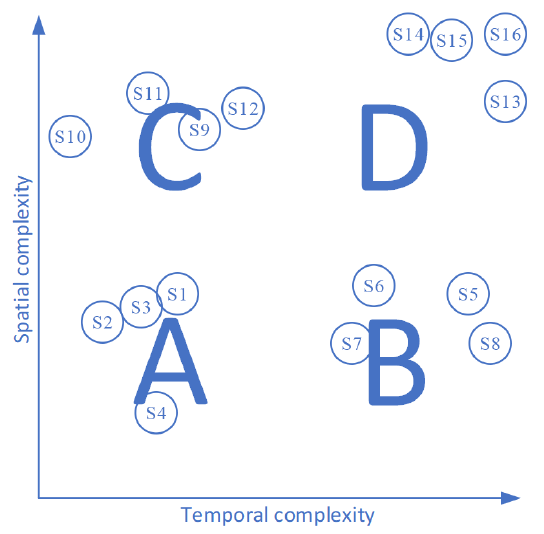
Figure 2. Sequence classification.